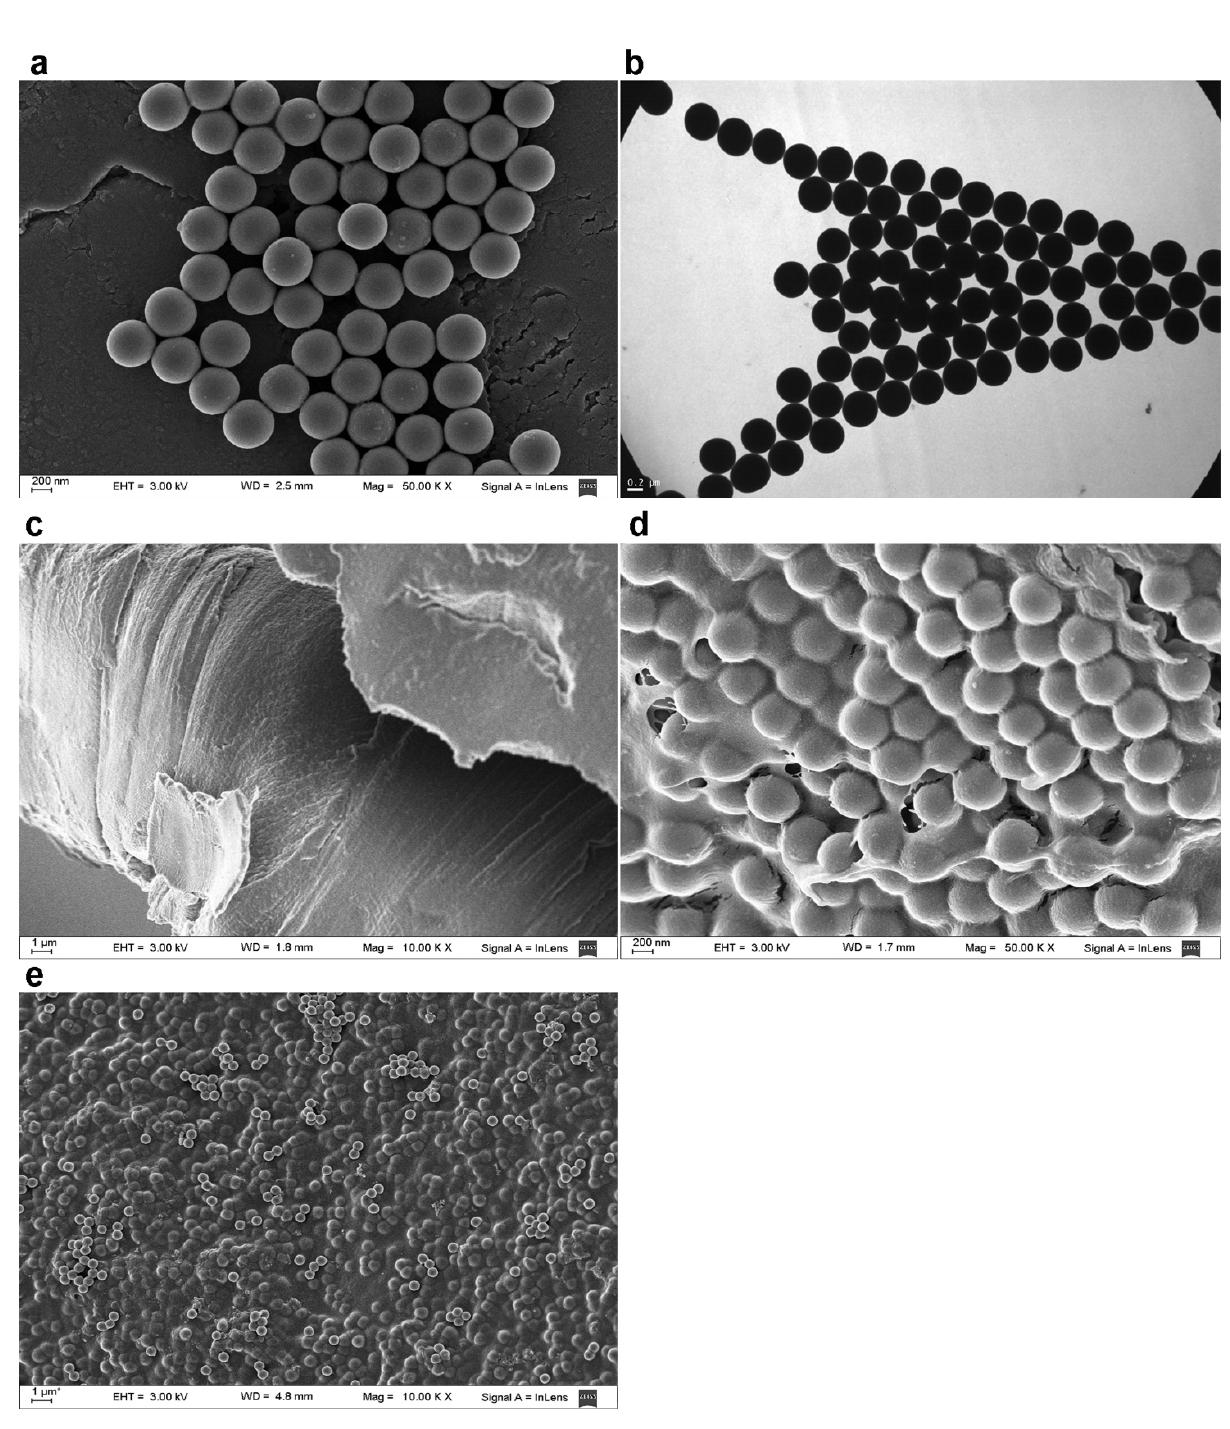
Figure 1. ( a ) Representative SEM image of Sol-Si particles; ( b ) representative TEM image of Sol-Si particles; ( c ) representative SEM image of CS; ( d , e ) representative SEM image of the (CS/Sol-Si) biocomposite. Table 1. DLS characterization of Sol-Si particles.